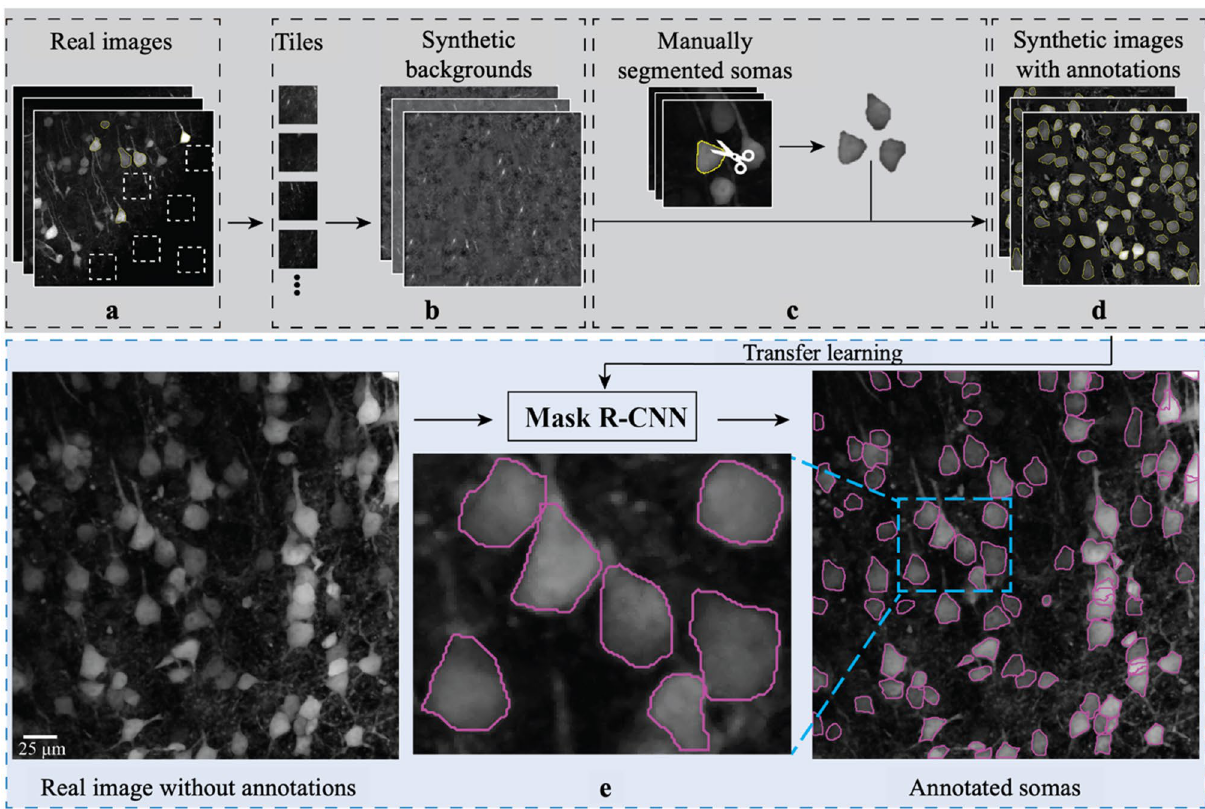
Figure 1. ANMAF development. ( a ) A library of background tiles was constructed from the background of multiple two-photon images. ( b ) The background tiles were shuffled and arbitrarily placed to produce a collection of random synthetic backgrounds. ( c,d ) Somatic areas from the original human detected neurons were cut, pasted, and blended into randomly selected backgrounds to generate multiple synthetic images. ( e ) The Mask R-CNN model was initiated with parameters transferred from a pre-trained model and fine-tuned with synthetic images from the previous steps. Once trained, the ANMAF generated somatic contours from a given neuronal input